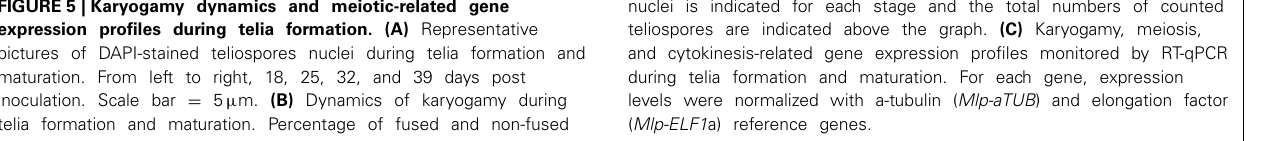
FIGURE 5 | Karyogamy dynamics and meiotic-related gene expression profiles during telia formation. (A) Representative pictures of DAPI-stained teliospores nuclei during telia formation and maturation. From left to right, 18, 25, 32, and 39 days post inoculation. Scale bar = 5 μ m. (B) Dynamics of karyogamy during telia formation and maturation. Percentage of fused and non-fused